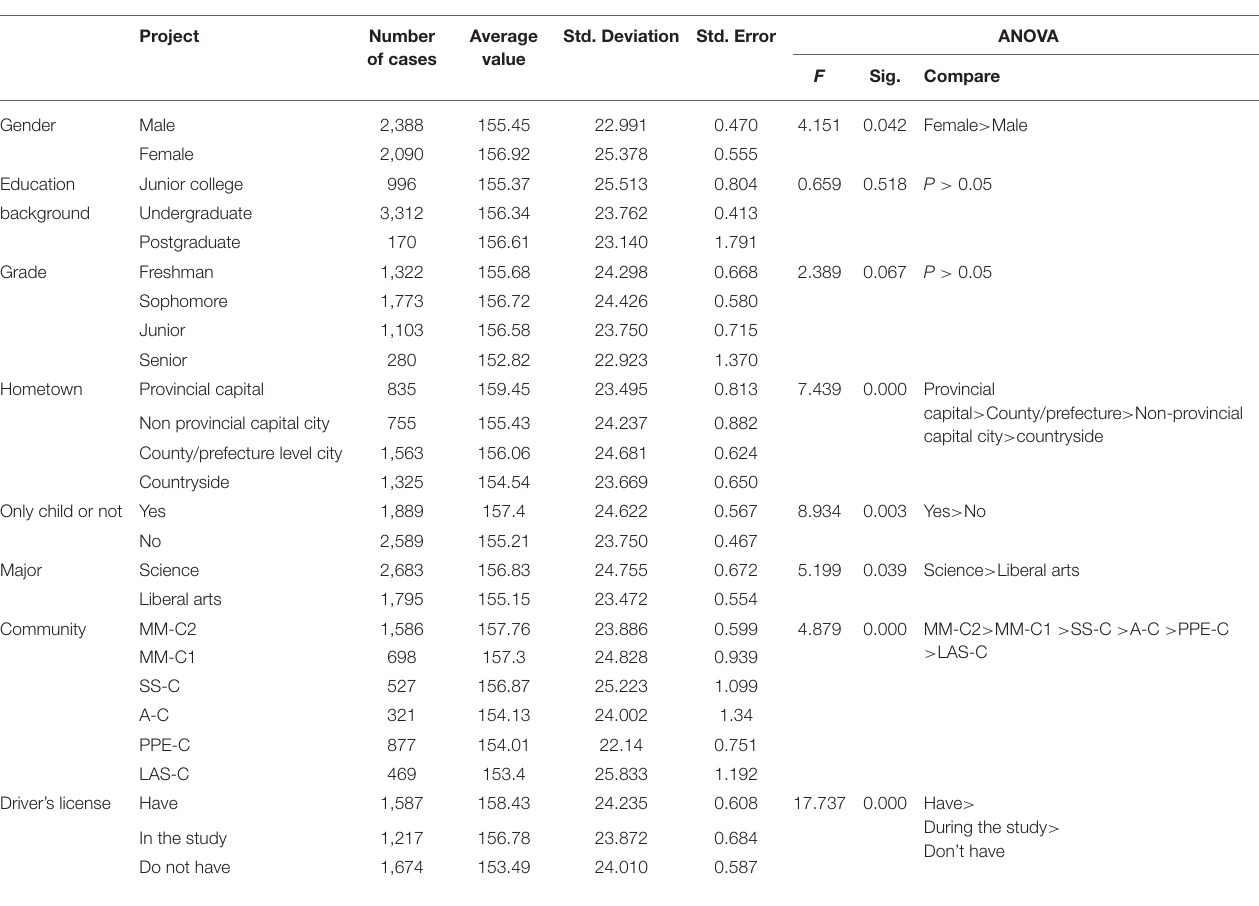
TABLE 7 | Analysis of variance of influencing